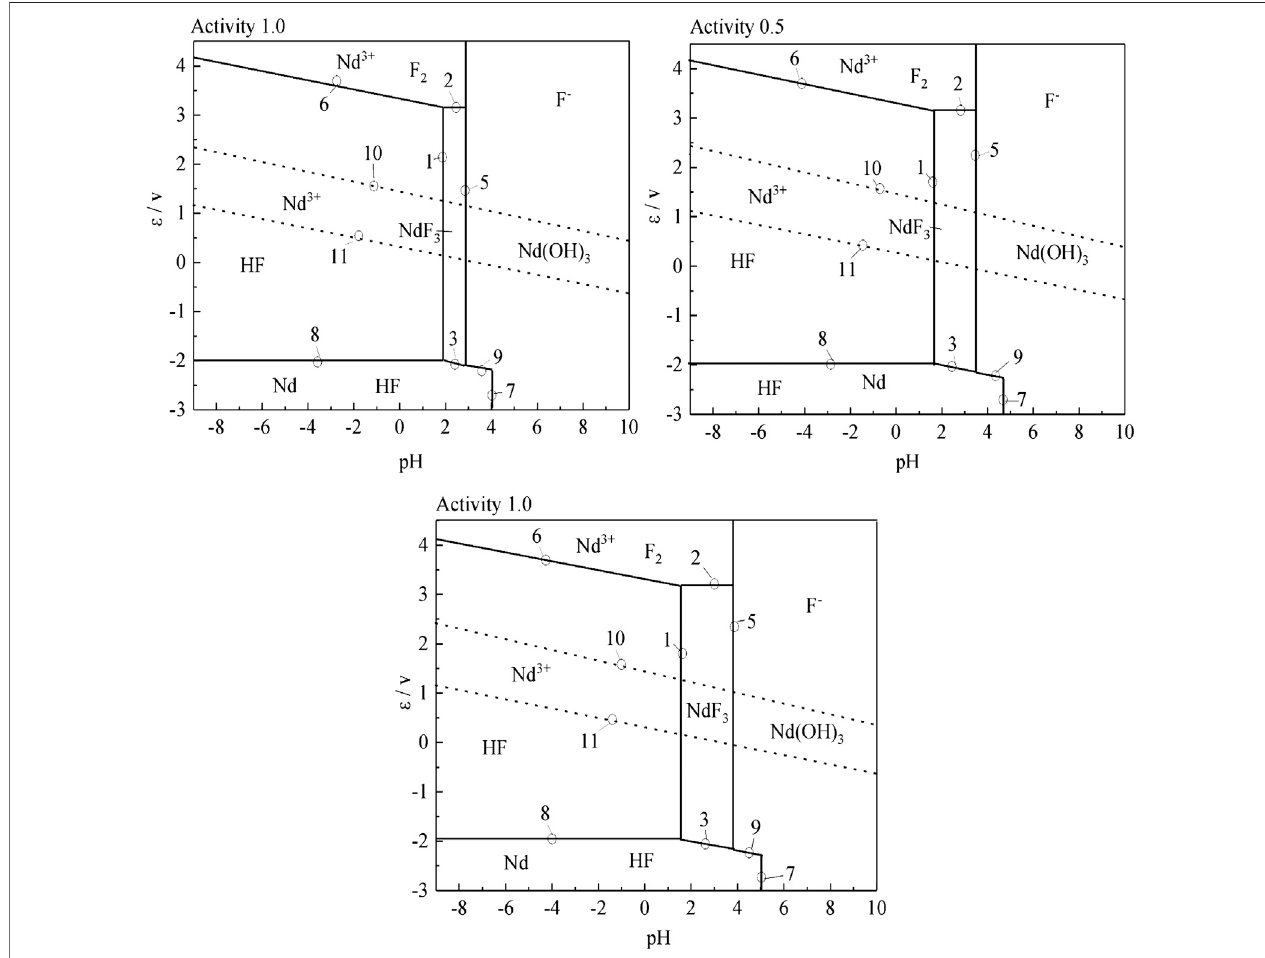
FIGURE 7 | ε -pH diagram of the Nd-F-H 2 O system with different activities at 663 K.